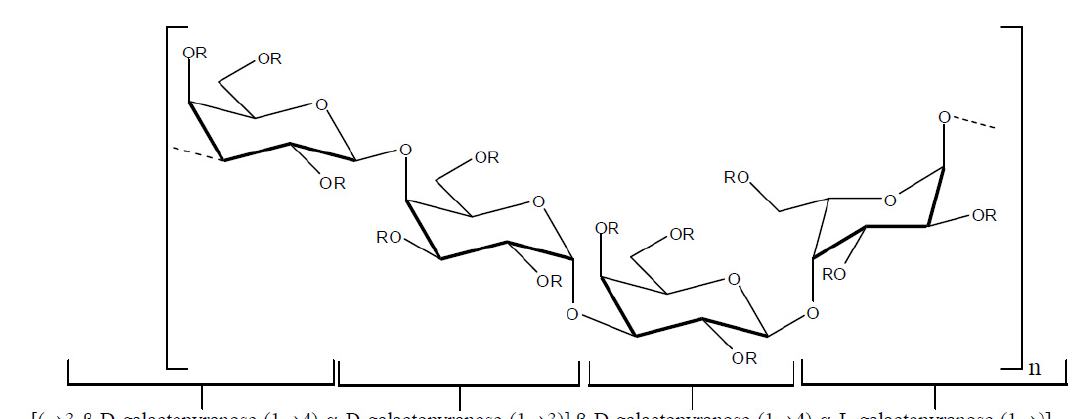
Figure 4. Basic repeating unit of DL -hybrid galactans.